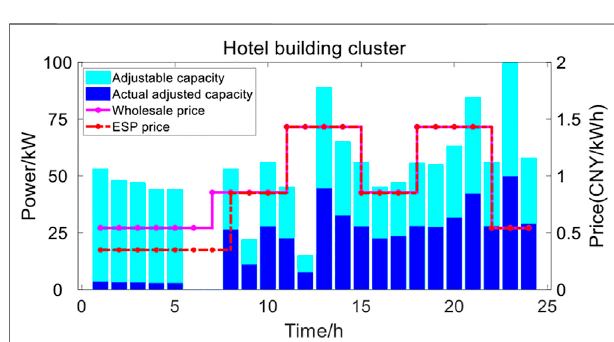
FIGURE 9 | Pricing decision-making results of hotel building